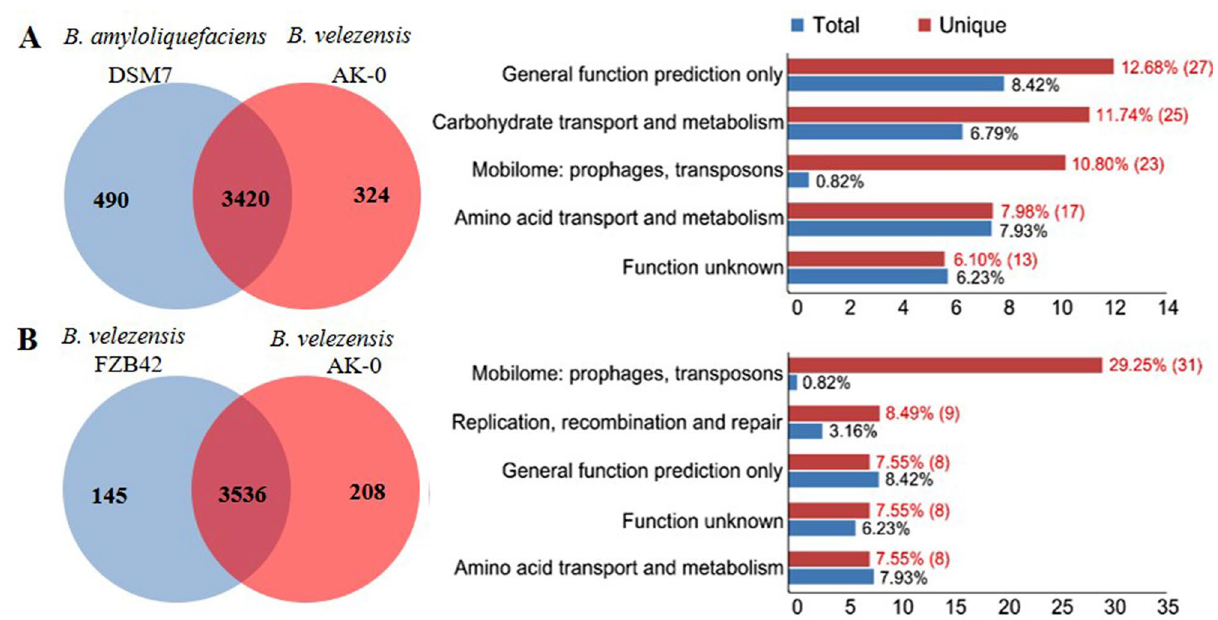
Figure 4. Venn diagram showing the comparison of common sharing unique protein-encoding genes between Bacillus velezensis AK-0 and B. amyloliquefaciens DSM7 ( A ), and B. velezensis FZB42 and B. velezensis AK-0 ( B ). A summary of unique SNPs from the total genes of the B. velezensis strain is shown here. The numbers 3420 and 3536 indicate the number of common high-expression gene families between the two strains DSM7 and AK-0 and between the other two strains FZB42 and AK-0,